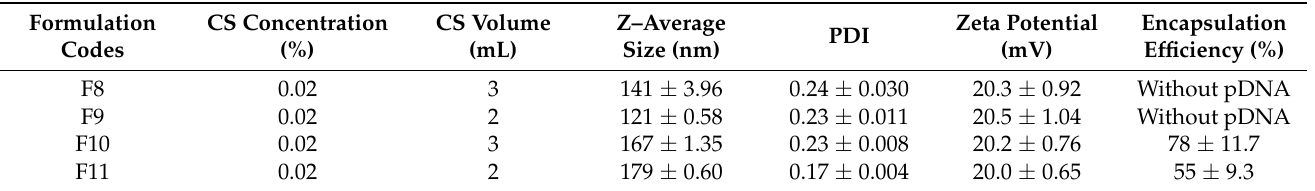
Table 3. Formulations and respective characterization results of CS-TPP and CS-TPP-pDNA obtained with 0.25 mL of TPP (0.05%) and varying the CS (0.02%)